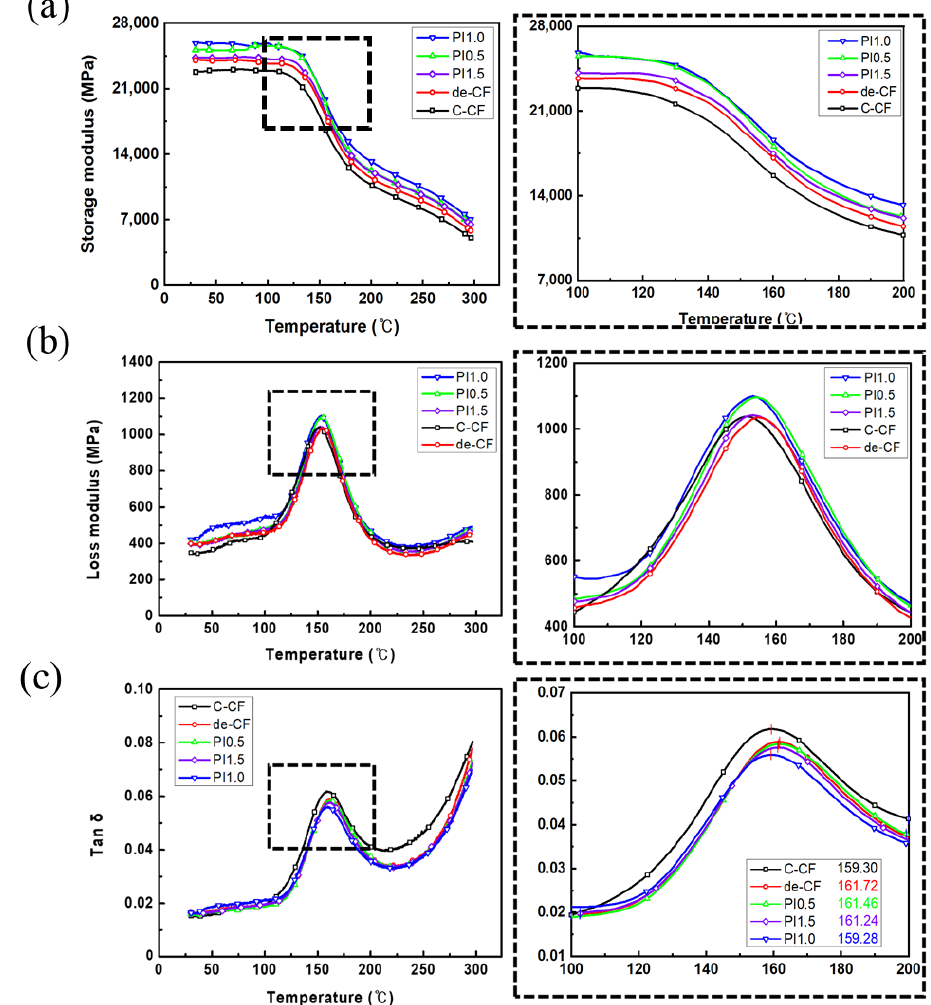
Figure 10. ( a ) Storage moduli, ( b ) loss moduli, and ( c ) tan δ curves for the composites reinforced with C−CFs and de−CFs, as well as PI 0.5 wt%, PI 1.0 wt%, and PI 1.5 wt% of PI−sized CFs.